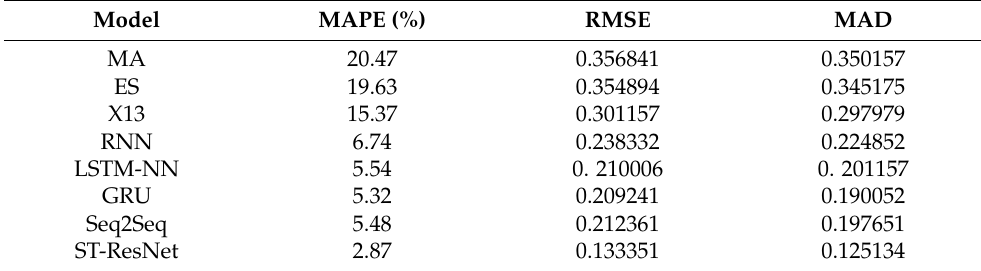
Table 3. Comparison of short-term forecasting